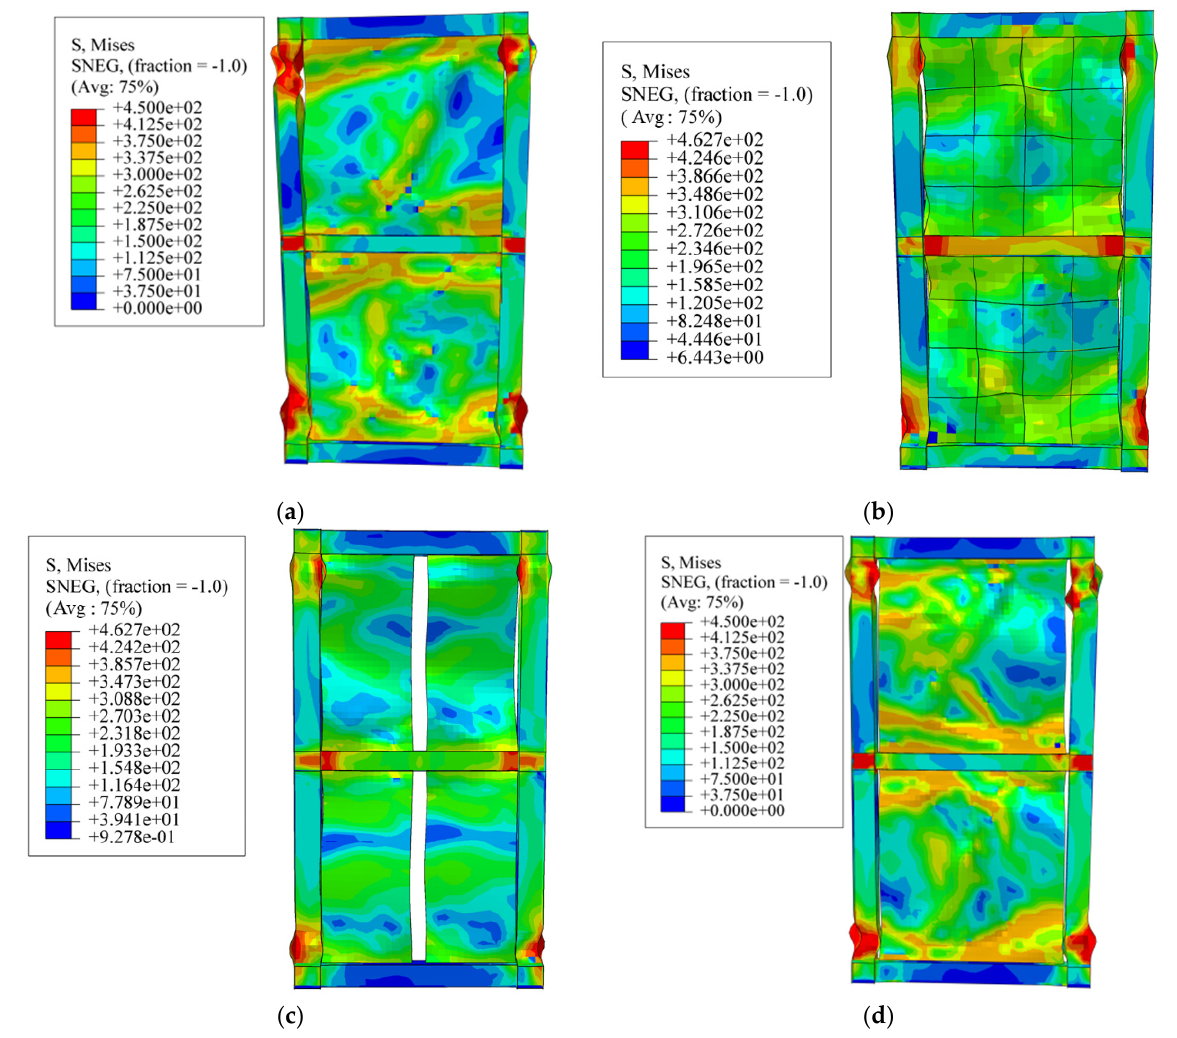
Figure 12. Stress distribution of damaged FEM specimens: ( a ) FSPSW; ( b ) OSPSW; ( c ) VSSPSW; ( d ) BSPSW.